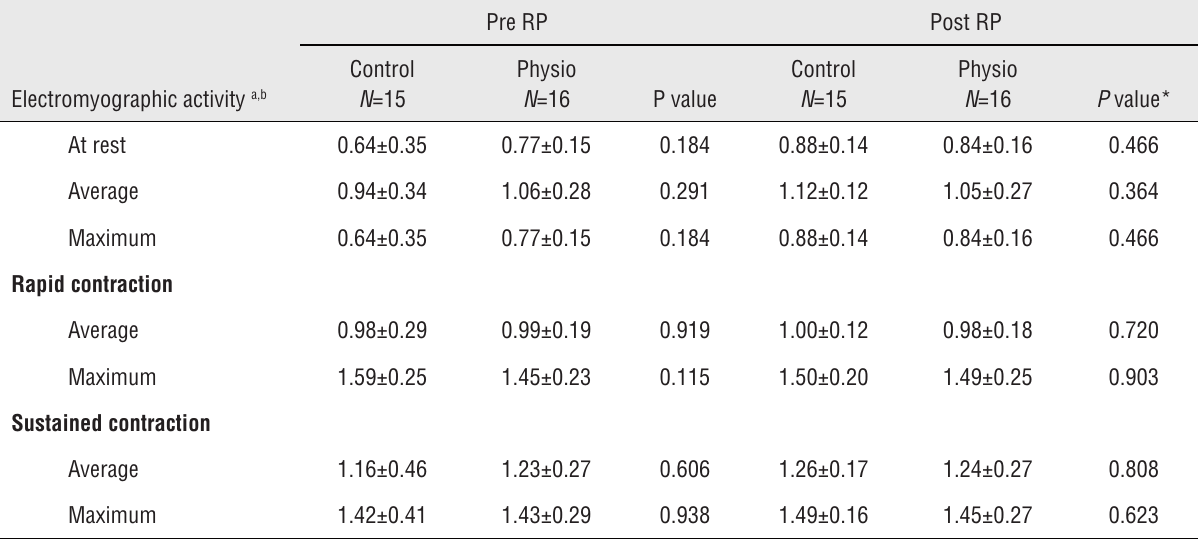
Table 3 - Electromyographic activity recorded at rest and during rapid and sustained contraction of the external anal sphincter of men submitted (Physical Therapy Group) or not submitted (Control Group) to pelvic floor muscle training before and after radical prostatectomy